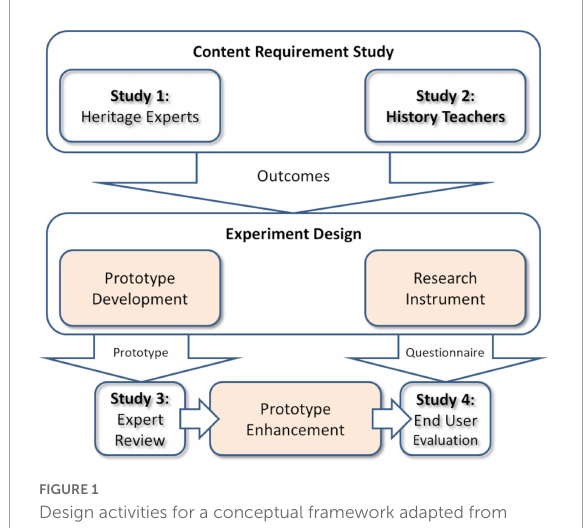
FIGURE1 Design activities for a conceptual framework adapted from Ibrahim and Ali